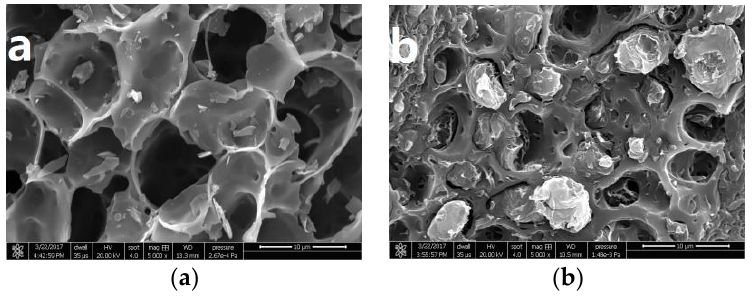
Figure 7. SEM images of ( a ) biochar and ( b ) the broken impact sections of composites.